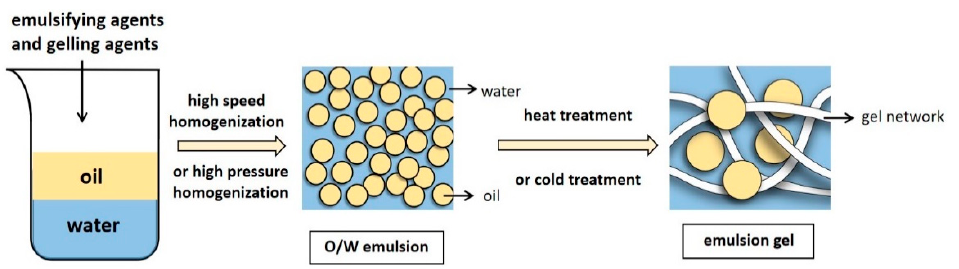
Figure 1. The preparation process of O/W emulsion gels.